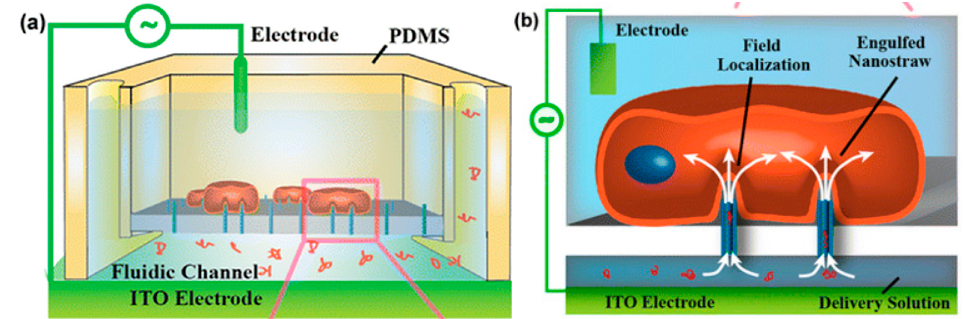
Figure 10. ( a ) Schematic diagram of nano-straw-electroporation platform. ( b ) Schematic of field localization and confinement of biomolecule at the nano-straw tip. Reprinted with permission from ref. [109]. Copyright © 2013 American Chemical Society.